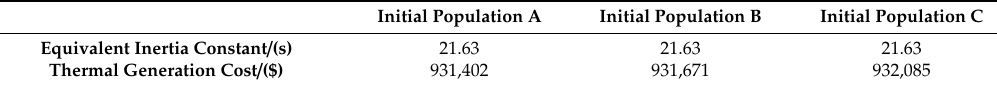
Table 9. Comparation of objective results of JC thermal generation plant based on the above three initial populations.